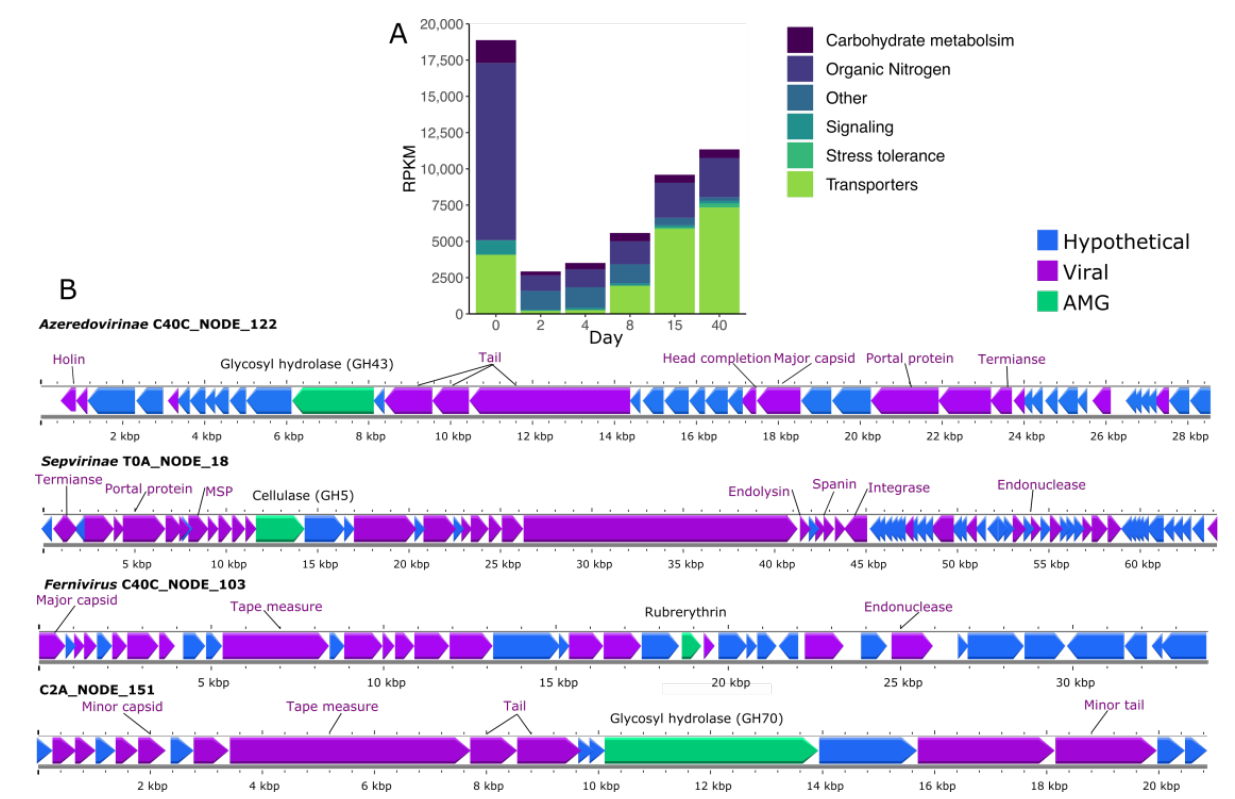
Figure 7. Potential auxiliary metabolic genes (AMGs) found in vOTUs during grass ensilaging. ( A ) Relative abundance of AMGs present in 11 vOTUs grouped by categories. ( B ) Examples of the genomic neighborhood of AMGs found in vOTUs during grass ensilaging. Known viral genes are colored purple, while AMGs and hypothetical genes are green and blue, respectively. Structural viral genes were annotated based on Virus Orthologous Groups (VOGDB) predictions. All genes were annotated using DRAM, and AMGs with flags related to viral (F), transposon (T), viral-like peptidase (P), or attachment flag (A) were discarded.